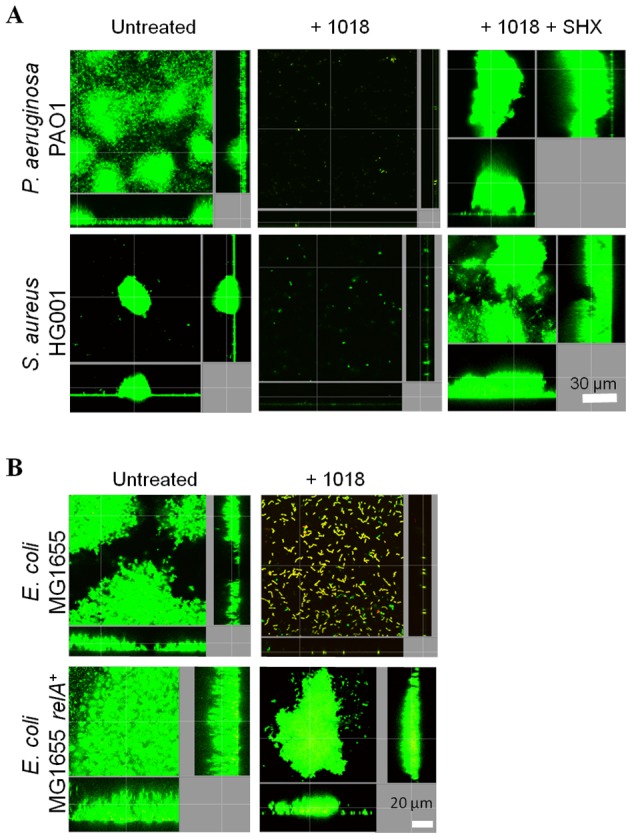
Enhanced (p)ppGpp production leads to altered susceptibility of biofilms to peptides.(A) Addition of SHX, which leads to overproduction of (p)ppGpp, resulted in the resistance of biofilm development to 20 µg/ml of peptide 1018; (B) (p)ppGpp overproduction through relA overexpression led to anti-biofilm peptide resistance. (A–B) Inhibition of biofilm development was tested by immediately adding 20 µg/ml 1018 (± SHX or IPTG) into the flow-through medium of the flow cell apparatus and then monitoring biofilm formation for 3 days. After 3 days, bacteria were stained green with the all bacteria stain Syto-9 prior to confocal imaging. Each panel shows reconstructions from the top in the large panel and sides in the right and bottom panels (xy, yz and xz dimensions).